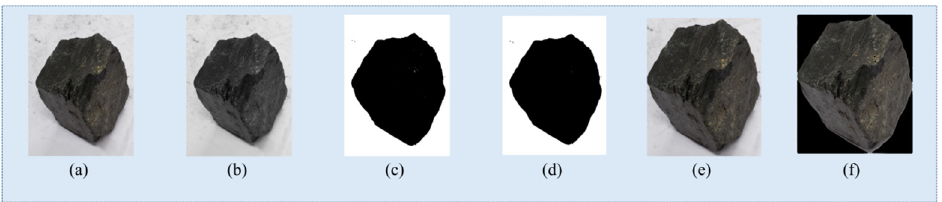
Figure 6. Intermediate results in preprocessing procedures. ( a ) A sample original image; ( b ) Blur operation; ( c ) Binarization operation; ( d ) Erosion and dilation operation; ( e ) Edge detected and bounding-box acquired from binary image and utilized to segment object from original image. ( f ) Background noise reduced with black color filling.